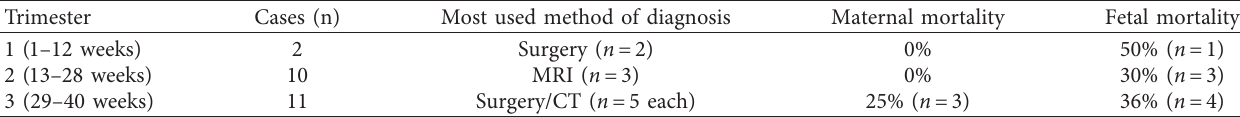
Table 2: Summary of midgut volvulus by trimester